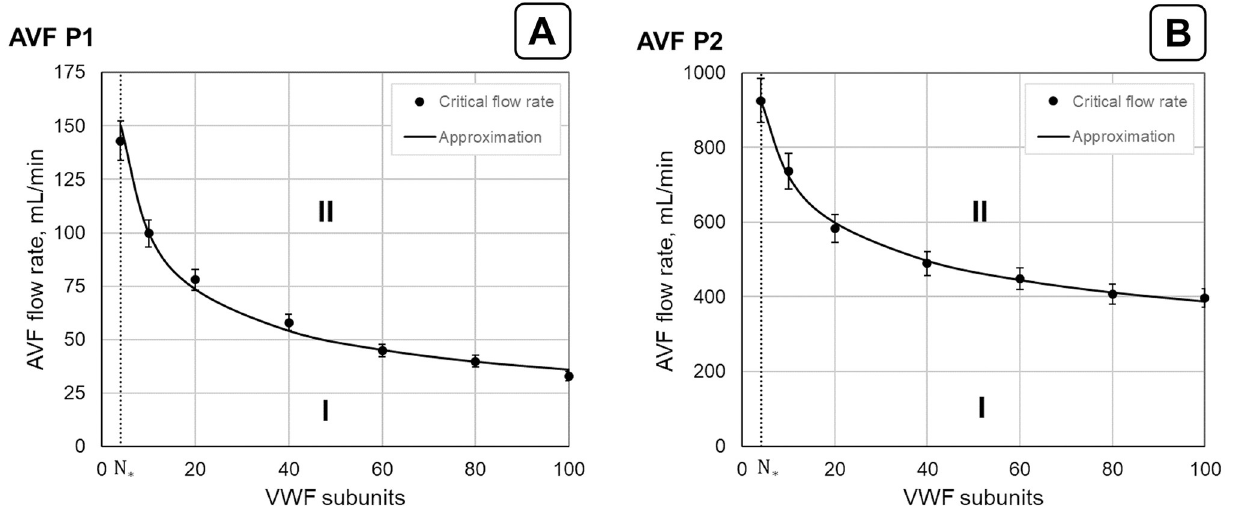
Fig 7. Parametric diagram of SIPAct in P1 (A) and P2 (B) AVFs. Region I corresponds to the values of the parameters at which no SIPAct should be observed. Region II represents the values of the parameters at which SIPAct can occur. The solid lines approximate the dependence of the critical flow rate ( Q cr ) on the VWF multimer size. The value N � ( N � = 4) is the minimum number of VWF monomers when the approach used in this work is applicable [24]. The parameter values of the approximation curves are given in S6 Text.